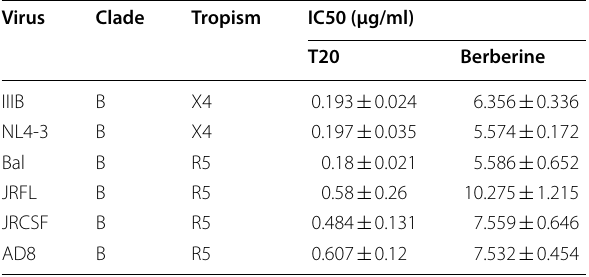
Table 2 Berberine potently inhibited infection of HIV-1 Env-pseudotyped